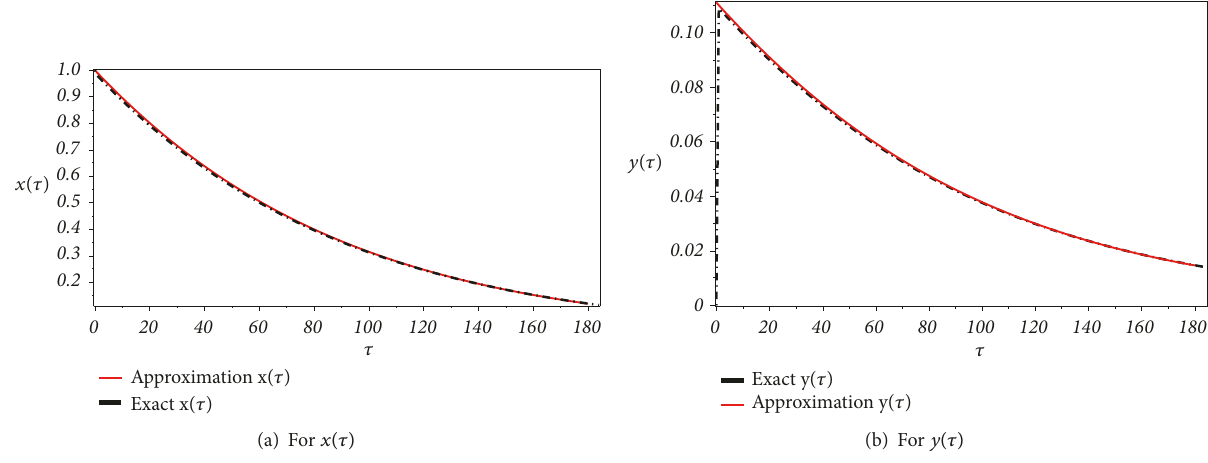
Figure 1: Comparison between numerical solutions and approximations (37) and